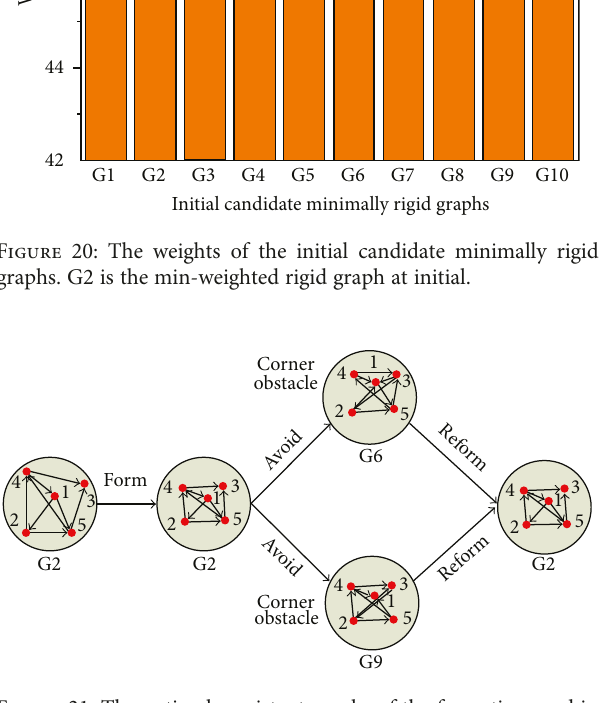
Figure 21: The optimal persistent graphs of the formation used in the optimized mode.